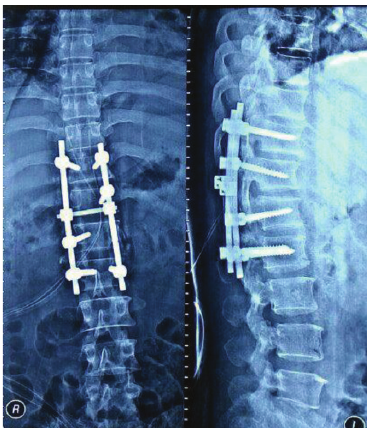
Figure 5: AP and lateral post-op X-rays of the patient showing posterior stabilization with pedicle screw and rod system and posterolateral fusion (taken on 21 June